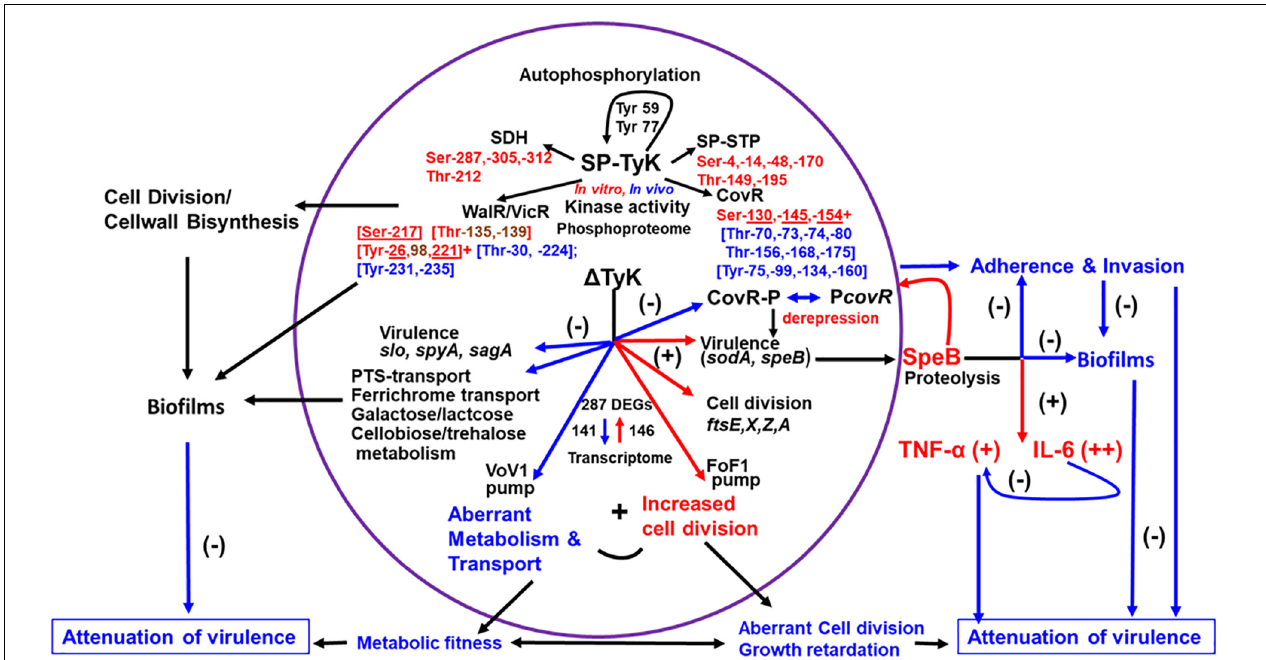
FIGURE 9 | Schematic diagram showing the role of SP-TyK in GAS pathophysiology. SP-TyK, belonging to a class of ubiquitous bacterial kinase (UbK) enzymes, shows a tyrosine kinase activity during autophosphorylation targeting its Tyr59 and Tyr77 residues. However, during kinase activity on specific substrates, it shows dual specificity targeting Ser and Thr residues, as indicated and revealed based on Mass-spectrometric-based phosphoproteomic analysis. The residues in red and blue fonts represent in vitro and in vivo phosphorylated residues. The underlined residues in red fonts were detected both in vitro and in vivo conditions. The residues in brown fonts were detected only in vitro phosphorylation. The selection of SP-TyK substrates was based on RNA-seq-based transcriptome analysis and certain precedence described in the “Result” section. This analysis, as shown, identified a nearly equal proportion of down- ( − ) and upregulated ( + ) genes indicated with blue and red arrows, respectively. As shown, downregulated many types of transport and carbohydrate metabolism genes and some virulence genes result in compromised metabolic fitness. The upregulated cell division genes in conjunction with compromised metabolic fitness results in abnormal morphology and growth retardation. The observed differential virulence gene regulation results in attenuation of virulence properties of the mutant despite increased expression of speB . SpeB, being an important virulence factor, can play a dual role in regulating S. pyogenes virulence. As shown, SpeB, on the one hand, induces proinflammatory responses increasing TNF- α and IL-6 secretion. The sustained release of IL-6 dampens the expression of TNF- α , thus mitigating its adverse effect on the host. The increased expression of speB and, hence, the increased translated SpeB protein as an outcome of derepression of non-phosphorylated CovR in the absence of SP-TyK-mediated phosphorylation results in attenuation of the mutant’s virulence. This attenuation is likely due to the SpeB-mediated non-specific proteolytic activities on the bacterial surface proteins involved in adherence and invasion processes and biofilm formation and, in turn, can result in attenuation of virulence. As shown, in addition to the various functions of CovR, the functions of other proteins/regulators modulated by SP-TyK–mediated post-translational modifications can potentially contribute to S. pyogenes virulence. The virulence of S. pyogenes and its disease outcomes are multifactorial host-parasite relationships, and bacterial metabolism plays a critical regulatory role. SP-TyK, as depicted, plays an essential modulatory role in fine-tuning this regulation of pathophysiological processes that govern S. pyogenes